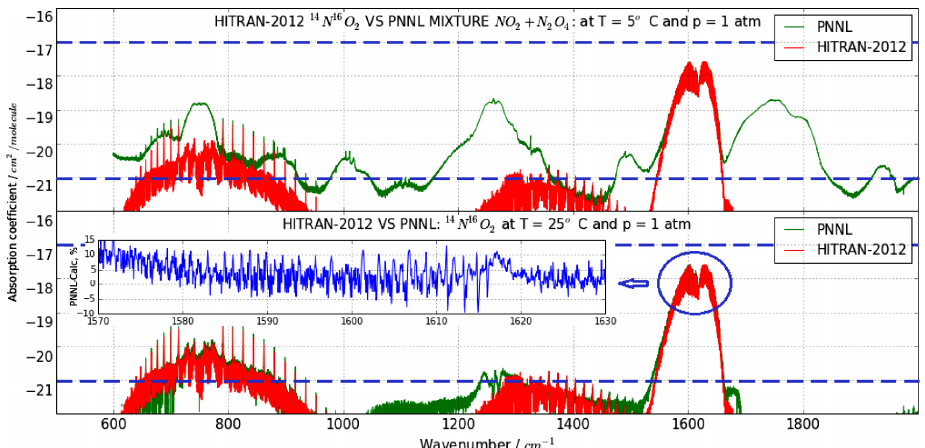
Figure 1. Comparison of HITRAN with PNNL: case of NO 2 . The top panel shows cross sections from PNNL for the mixture of N 2 O 4 and NO 2 (green trace) compared to HITRAN NO 2 data as was done in the BG article. The bottom panel compares NO 2 from PNNL to NO 2 in HITRAN showing very good agreement. The area inside the thick dashed horizontal grid lines corresponds to the area shown in the panels of Fig. 1 in the BG